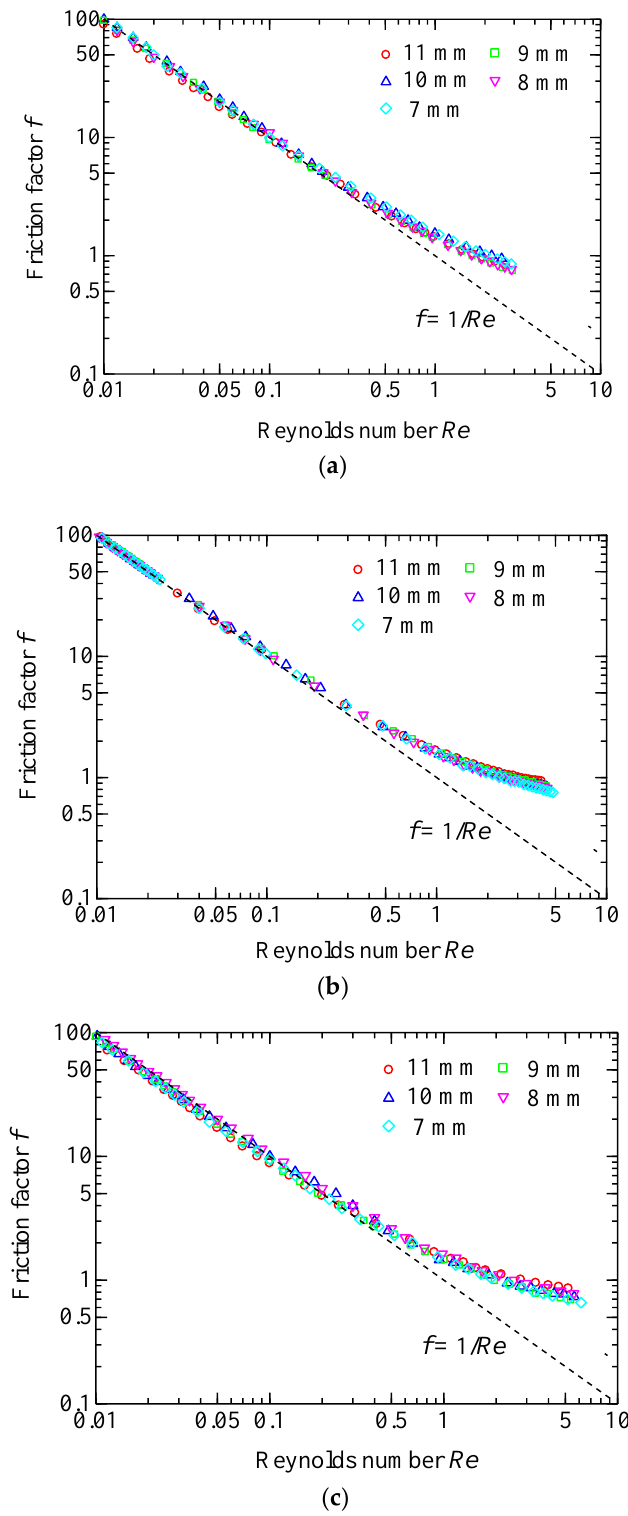
Figure 8. Friction factor f as a function of the Reynolds number Re for the porous media. ( a ) Group 1; ( b ) Group 2; ( c ) Group 3.